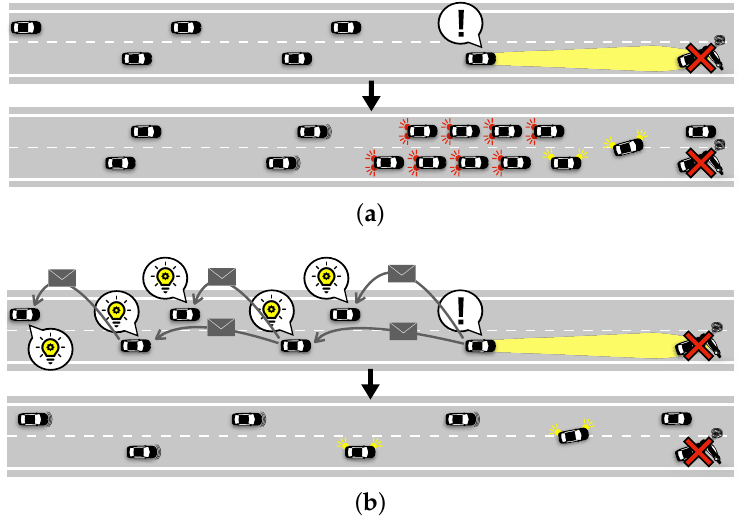
Figure 1. Obstacle avoidance using V2V communication. ( a ) Avoidance strategy when the obstacle’s existence cannot be shared via V2V communication. ( b ) Avoidance strategy when vehicles share the obstacle’s existence and location using V2V communication.